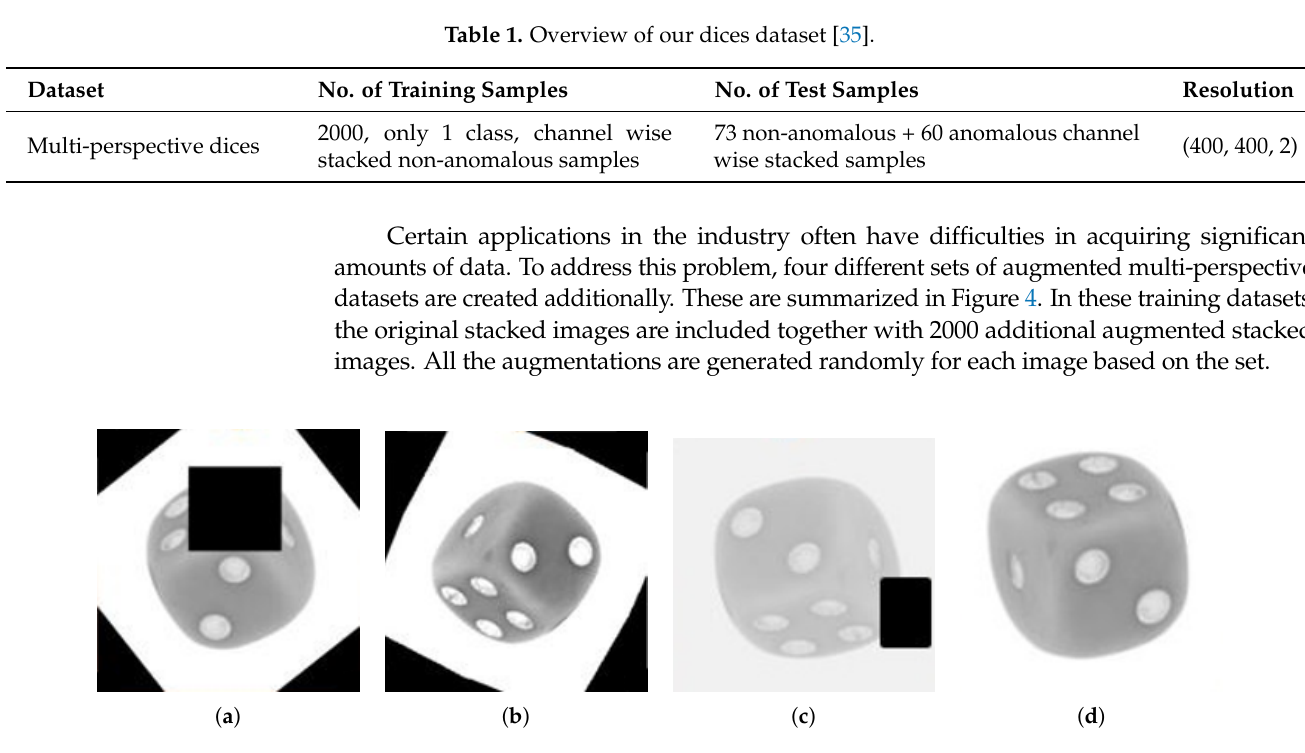
Figure 4. Four additional training sets are created that extend the original data with augmentation. Each set consists of 4000 channel wise stacked images (400,400,2). ( a ) The first set contains all augmentation strategies, i.e., erasing patches, changing image constituents like brightness and altering geometry like flipping. The other training sets exclude particular strategies: ( b ) w/o erased patching, ( c ) w/o change of image constitution and ( d ) w/o geometrical rotations and